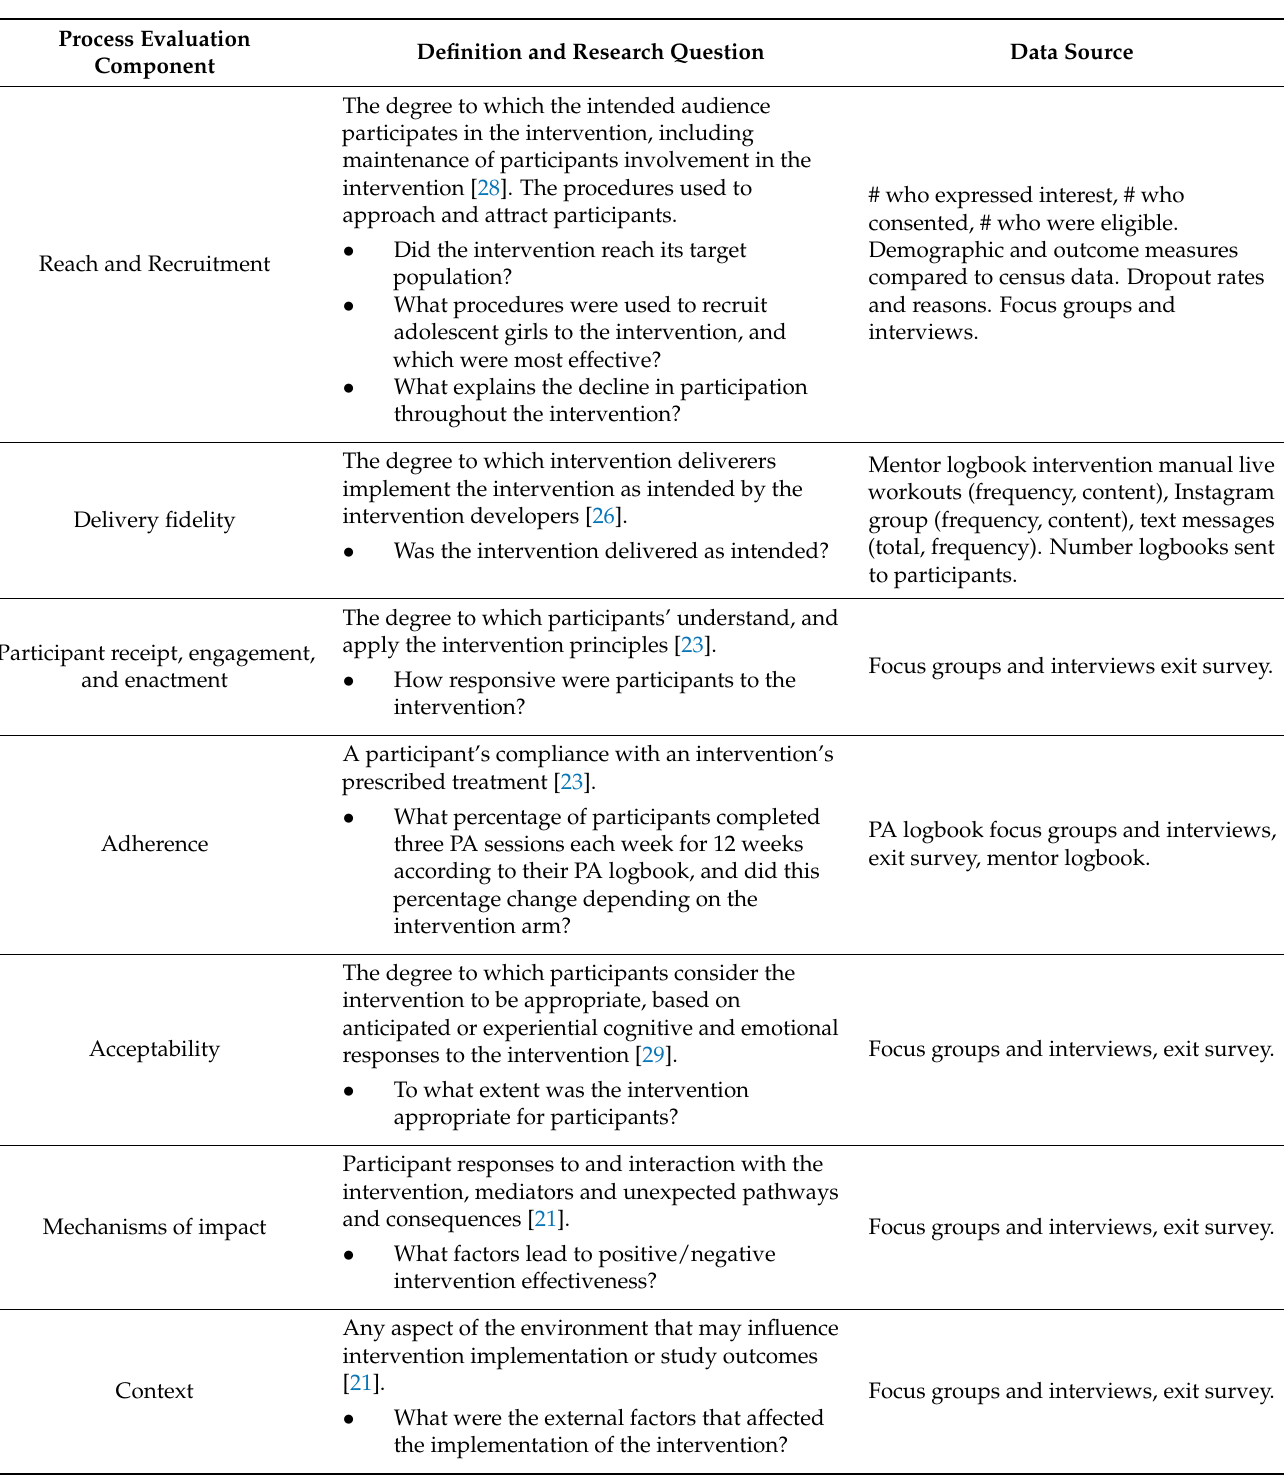
Table 2. Process evaluation definitions and the components used to address research